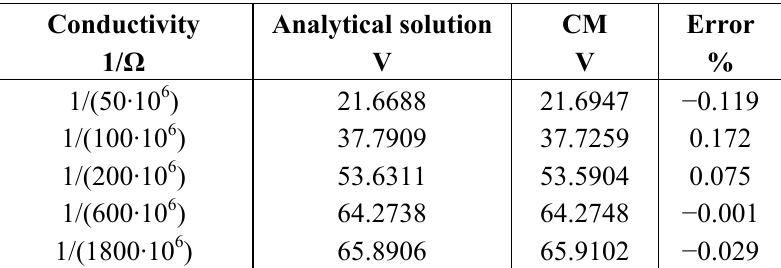
Table 3. Interface electrical